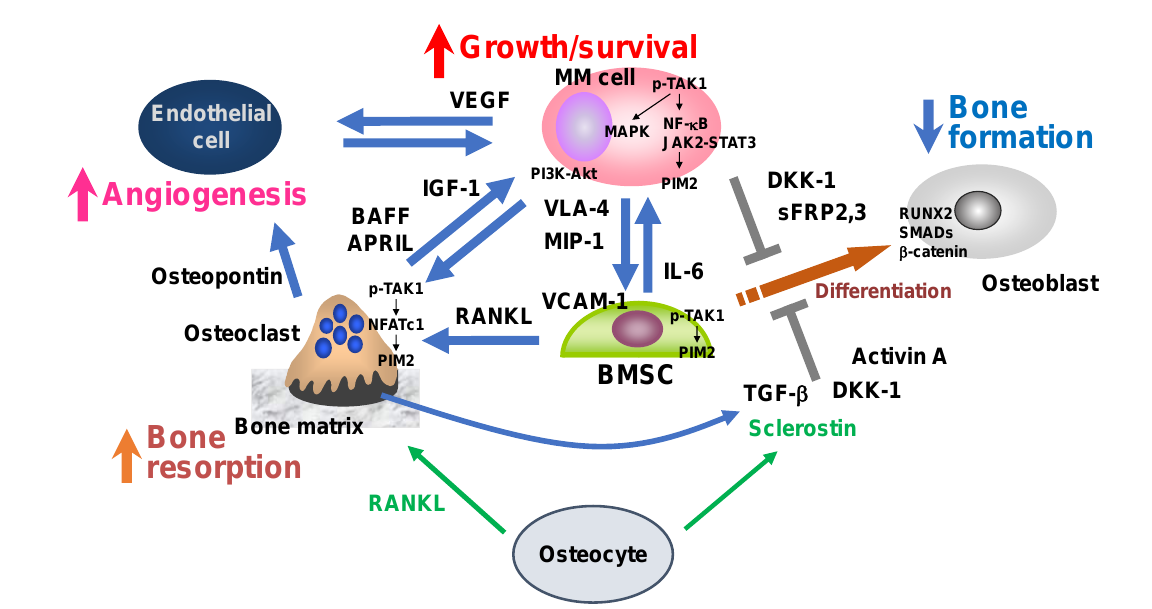
Figure 1. Bone destruction and MM niche. Myeloma (MM) cells stimulate bone resorption by enhancing osteoclastogenesis while suppressing bone formation by inhibiting osteoblastic differentiation from bone marrow stromal cells (BMSCs), leading to extensive bone destruction with rapid loss of bone. The TAK1–PIM2 axis is among major crucial signaling pathways in MM cells, BMSCs, and osteoclasts for MM progression and MM-related bone loss. Osteocytes embedded in the bone matrix produce RANKL and sclerostin to regulate bone metabolism. RANKL and sclerostin production by osteocytes are aberrantly increased in MM. Angiogenesis is also increased by multiple factors elaborated from osteoclasts and BMSCs as well as MM cells. MM-induced cell types in MM bone lesions, namely osteoclasts, vascular endothelial cells, and BMSCs with defective osteoblastic differentiation, create cellular microenvironments suitable for MM growth and survival and confer drug resistance to MM cells, which can be called an “MM